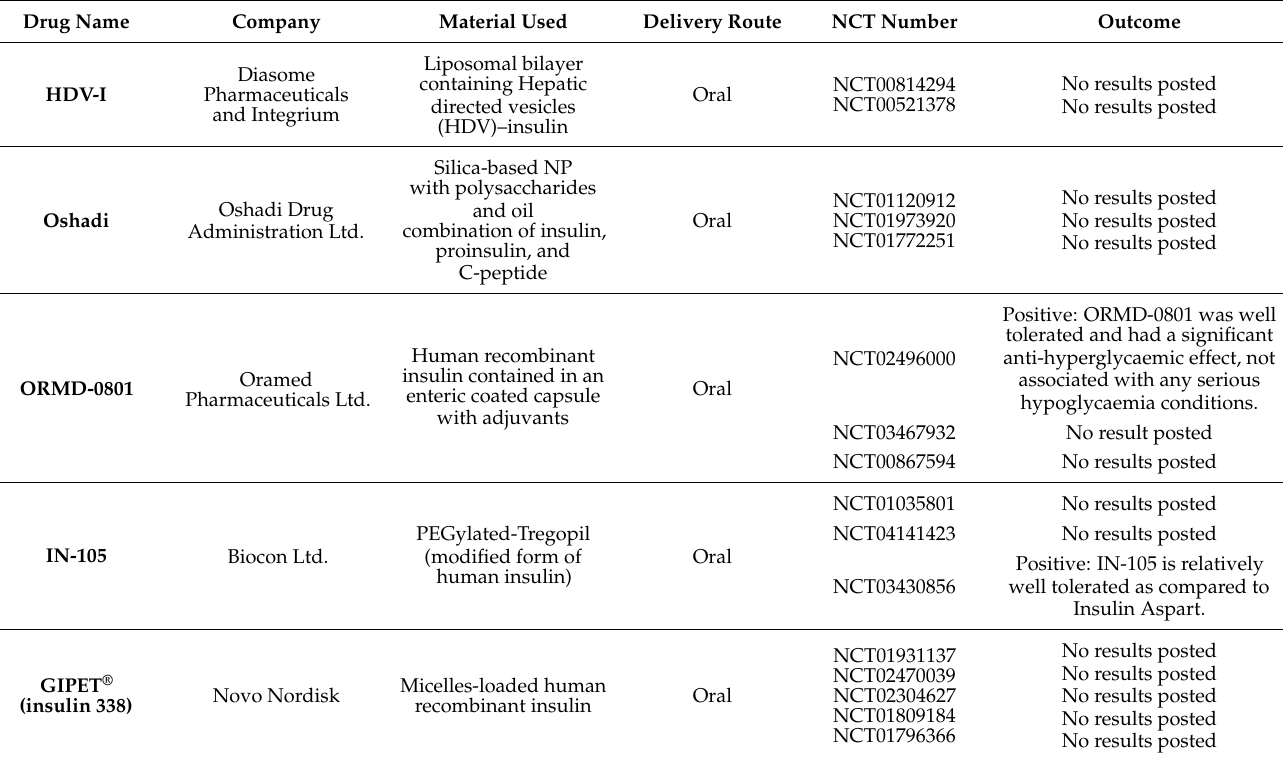
Table 3. List of new selected insulin-based nanomedicines in completed trials in recent